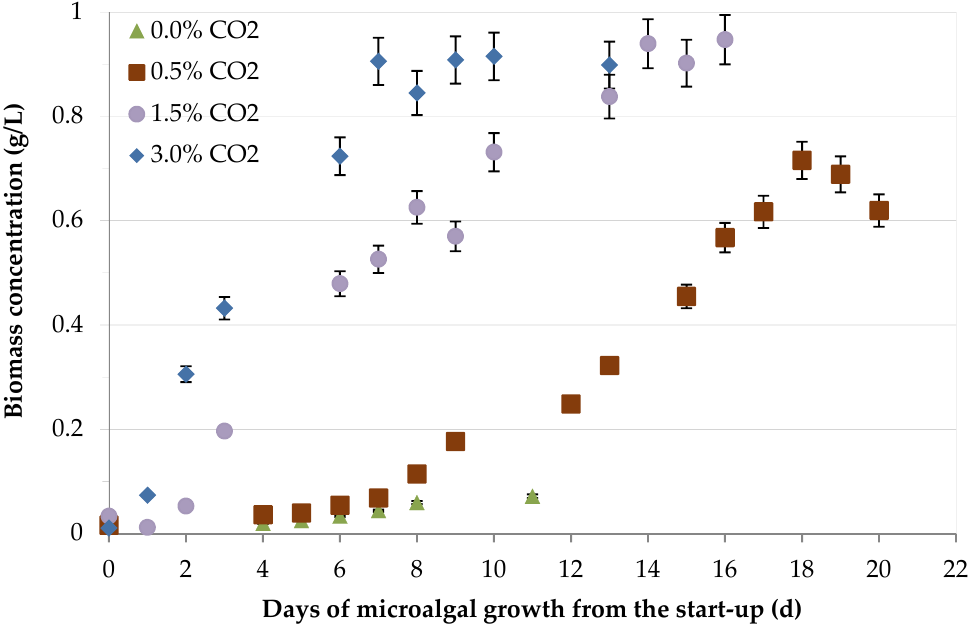
Figure 2. Effect of CO 2 content on S. almeriensis biomass concentration during cultivation.